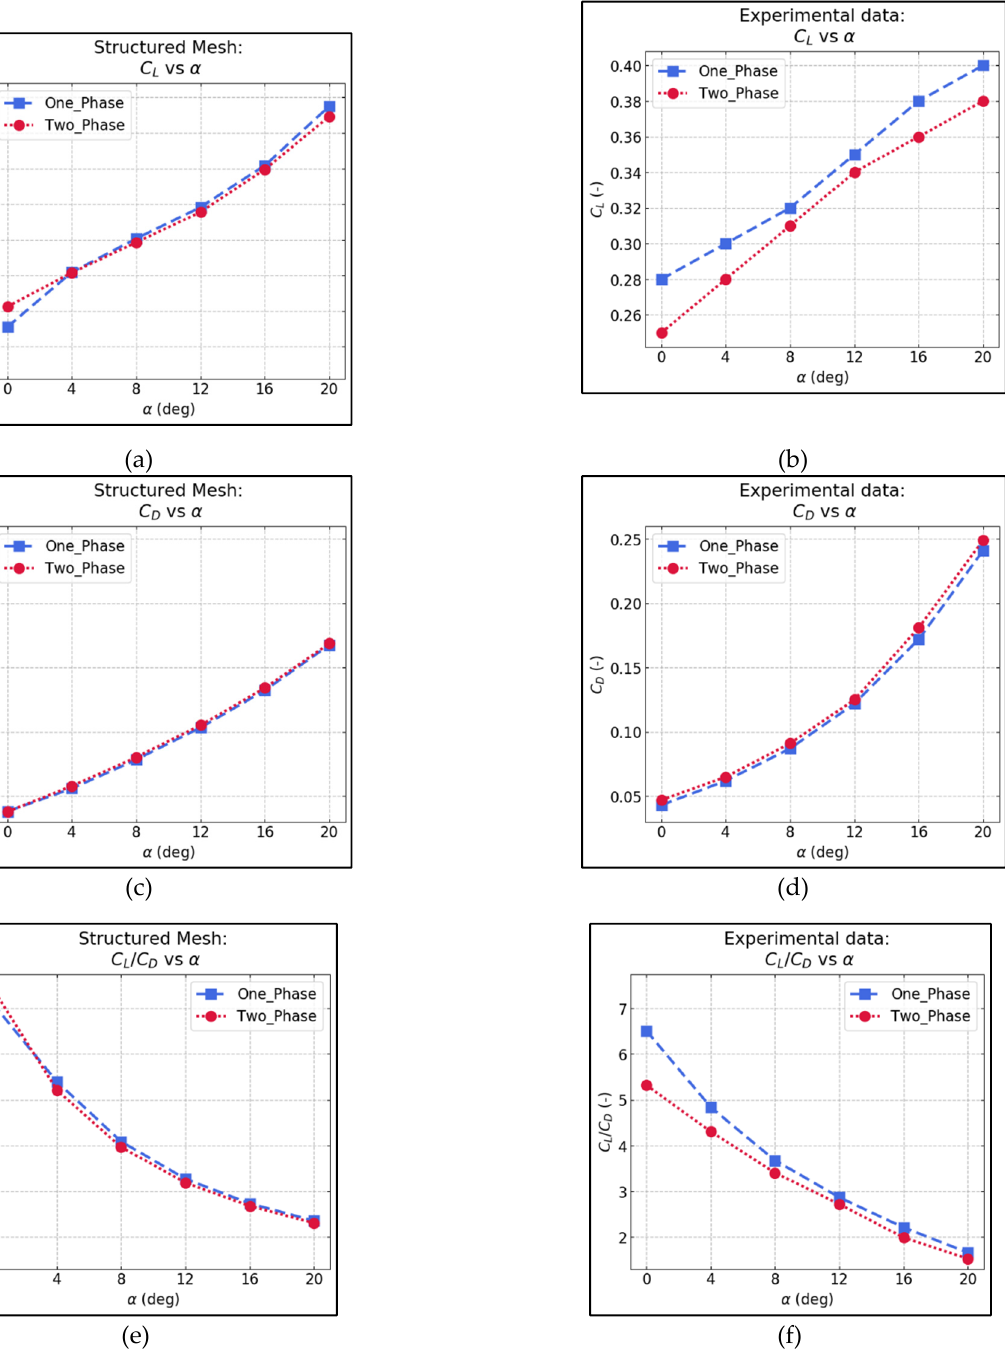
Figure 16. Comparison between one-phase and two-phase flow (air–sand) ( a ) Lift coefficient of wing in a structured mesh ( b ) Lift coefficient of wing in a subsonic wind tunnel ( c ) Drag coefficient of wing in a structured mesh ( d ) Drag coefficient of wing in a subsonic wind tunnel ( e ) Aerodynamic efficiency of wing in a structured mesh ( f ) Aerodynamic efficiency of wing in a subsonic wind tunnel.